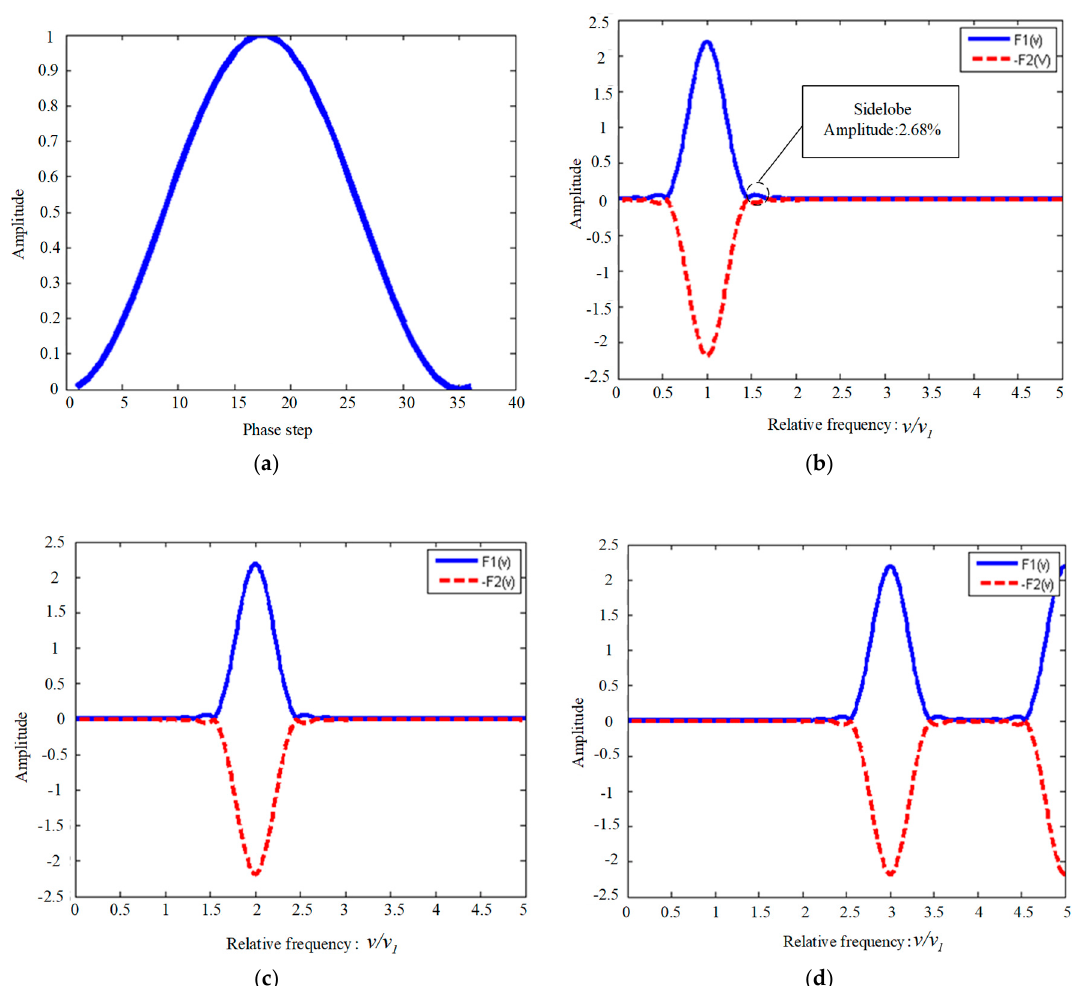
Figure 2. The Hanning window function. ( a ) Shape of the Hanning window function; ( b ) evaluating function of the Hanning window in the thickness measurement; ( c ) evaluating function of the Hanning window in the front-surface measurement; ( d ) evaluating function of the Hanning window in rear-surface measurement.